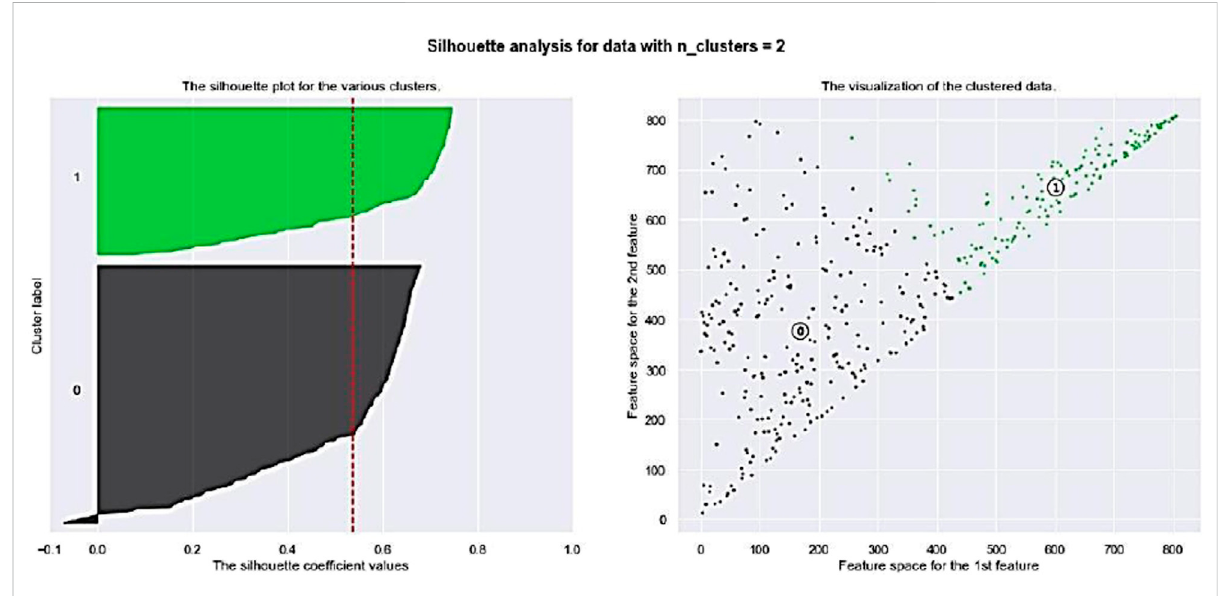
FIGURE 6 Silhouette with n_clusters = 2 for Hierarchical clustering.